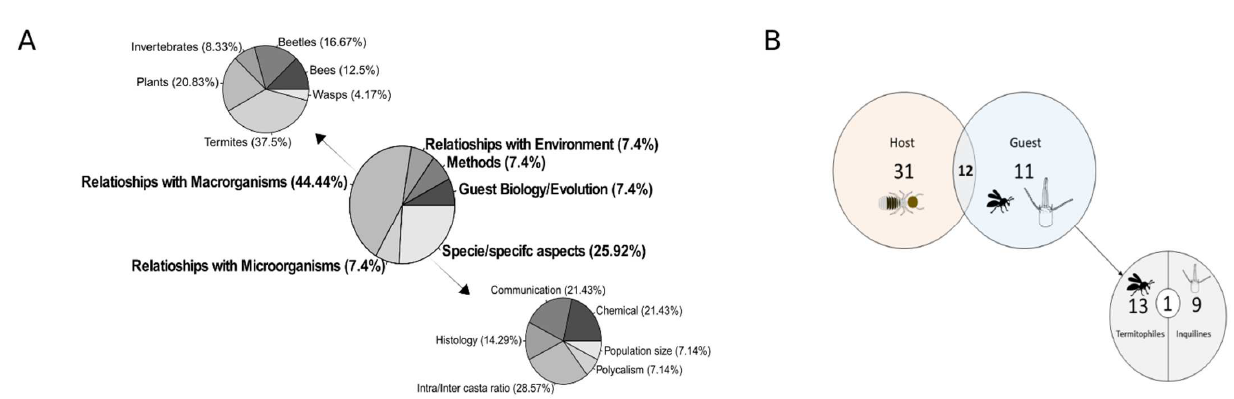
Figure 5. Analysis of content present in the papers analyzed. ( A ) The central pizza plot shows the fractions of the total number of papers ( n = 54). The top left piechart plot shows the divisions of papers produced inside the “Relationships with macroorganisms” category ( n = 24). The bottom right piechart shows the divisions of papers produced inside the “Species/specific aspects” category ( n = 14). ( B ) Number of papers produced which aimed C. cyphergaster (host), its guest (termitophiles/inquilines), and both (host/guest).